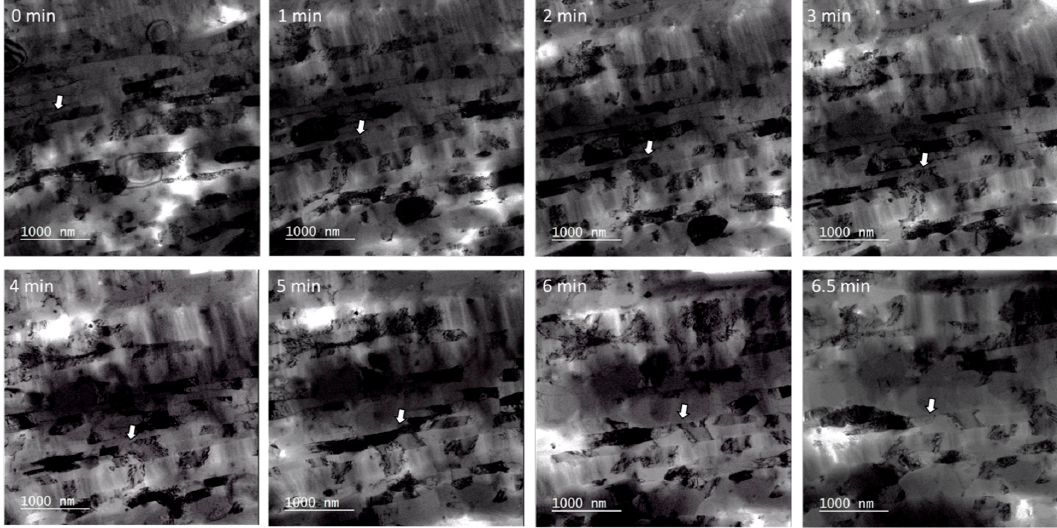
Figure 5. Snapshots of the microstructure evolution in 60% compressed 14YWT alloys at 1100 °C. The white arrows indicate the region evolving in time.